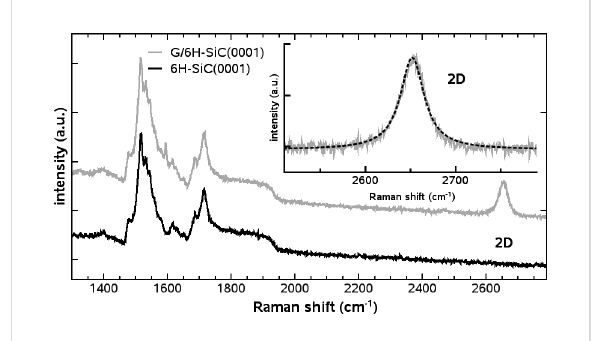
Figure 1: Micro-Raman spectrum for both, the substrate and the SLG flake introduced in Figure 3. The inset shows the 2D Raman peak and its Lorentzian fit.